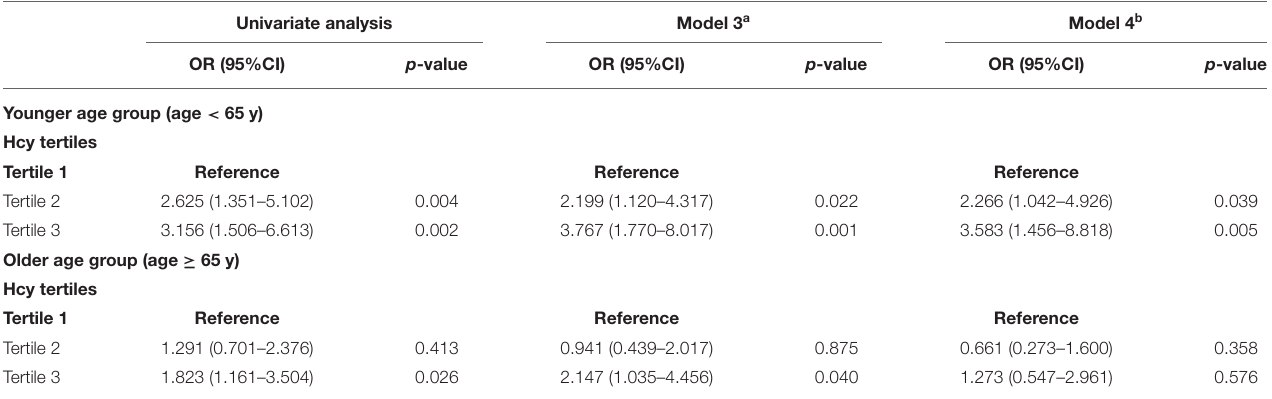
TABLE 5 | Multivariate adjusted odds ratios for the association between Hcy levels and cognitive impairment in the subcategorized groups of